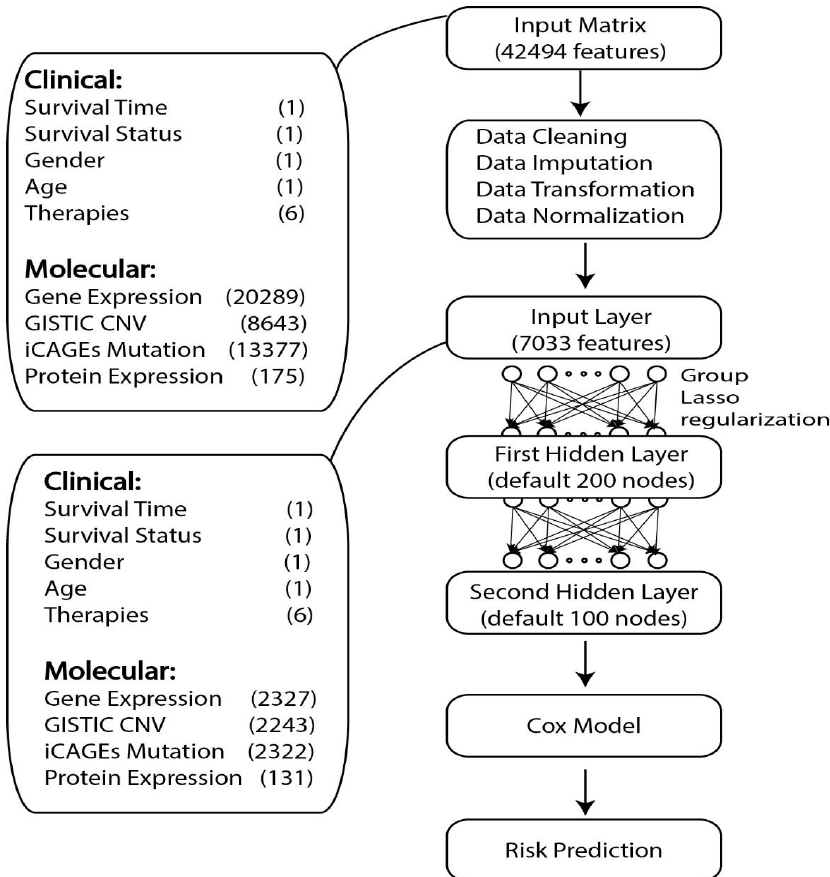
Figure 1. Basic framework of GDP. GDP can perform survival analysis for the cancer data with high-dimensional features. The number of features for each type of datasets is given in the parenthesis. GISTIC CNV means the CNV data was processed using GISTIC 2.0 and the focal data via gene output was used. Furthermore, iCAGES mutation means the DNA mutation data was processed using iCAGES and the iCAGES gene level scores were used. The number of molecular features shown here is the average number of molecular features from 14 TCGA tumor types selected in this